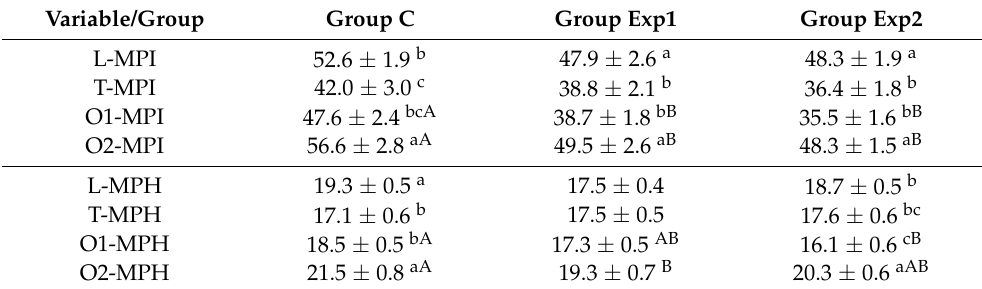
Table 3. Echotextural attributes of pectoralis major muscles in organic turkeys receiving three different